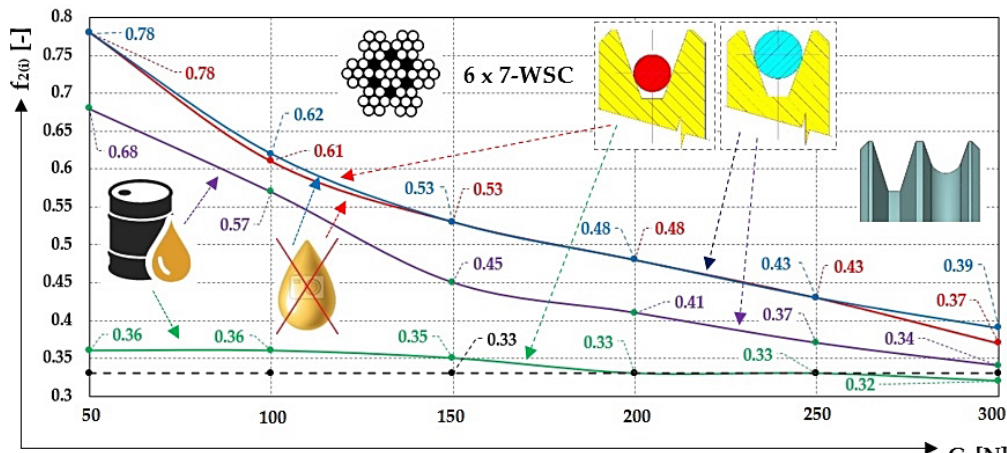
Figure 14. Measured values of friction coefficient f 2(i) [- ] in a V -shaped groove in a different state of the sheave groove contamination.